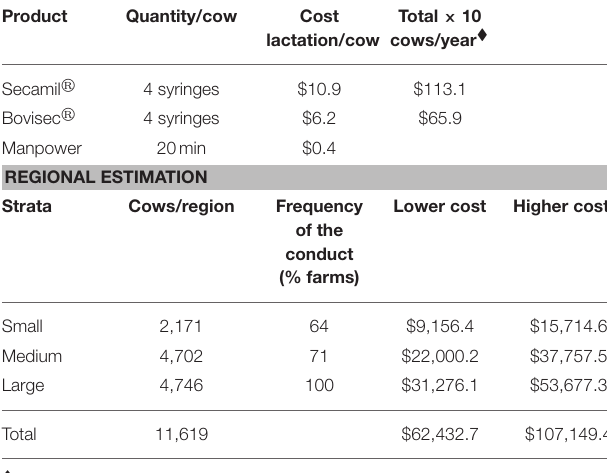
TABLE 6 | Cost estimation (US $) of a single treatment of cows at drying off, calculated for the two veterinary drugs of more frequent use in the region and calculated regional cost of the